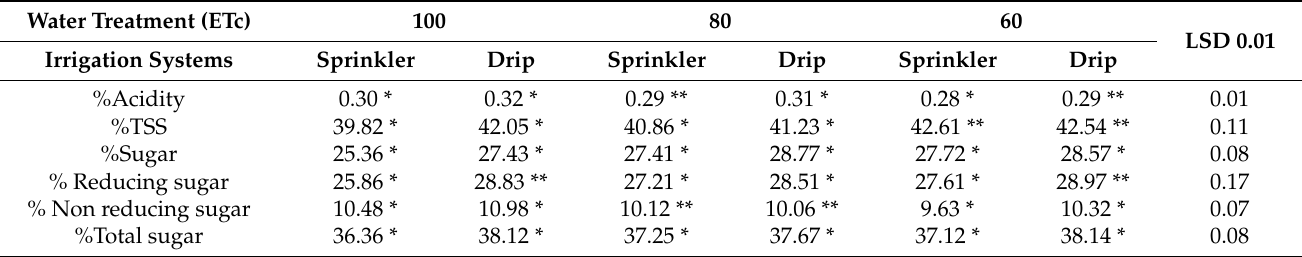
Table 6. Effect of different irrigation and water treatments on fruit acidity, TSS, total sugars, reducing and non-red sugars of date